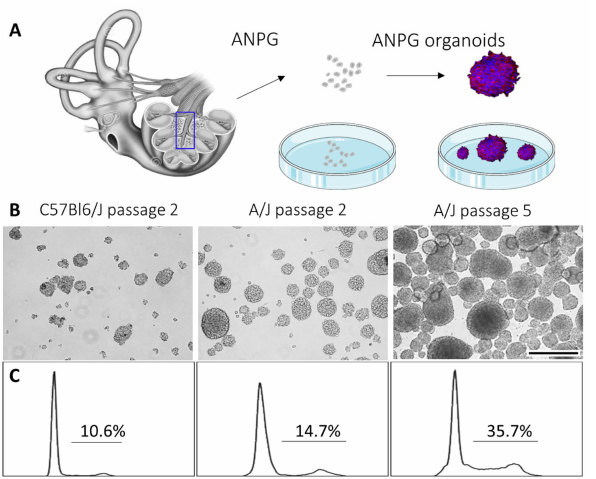
Figure 1. Generation of ANPGs organoids from C57Bl/6 and A/J mice . ( A ) ANPGs were isolated from the mouse pup spiral ganglion and cultured as single cell suspensions. Upon growth factor addition (FGF, EGF, IGF and heparan sulfate), ANPGs form organoids. ( B ) Bright-field microscopy pictures of ANPG organoids obtained from C57Bl/6 (left, at passage 2) A/J (middle, at passage 2) and A/J (right, at passage 5). Scale bar 500 µ m. ( C ) Cell cycle analysis of ANPG organoids obtained from C57Bl/6 (left, at passage 2) A/J (middle, at passage 2) and A/J (right, at passage 5), following DNA staining. Percentages indicated on the plots represent cells that are actively cycling (in phase